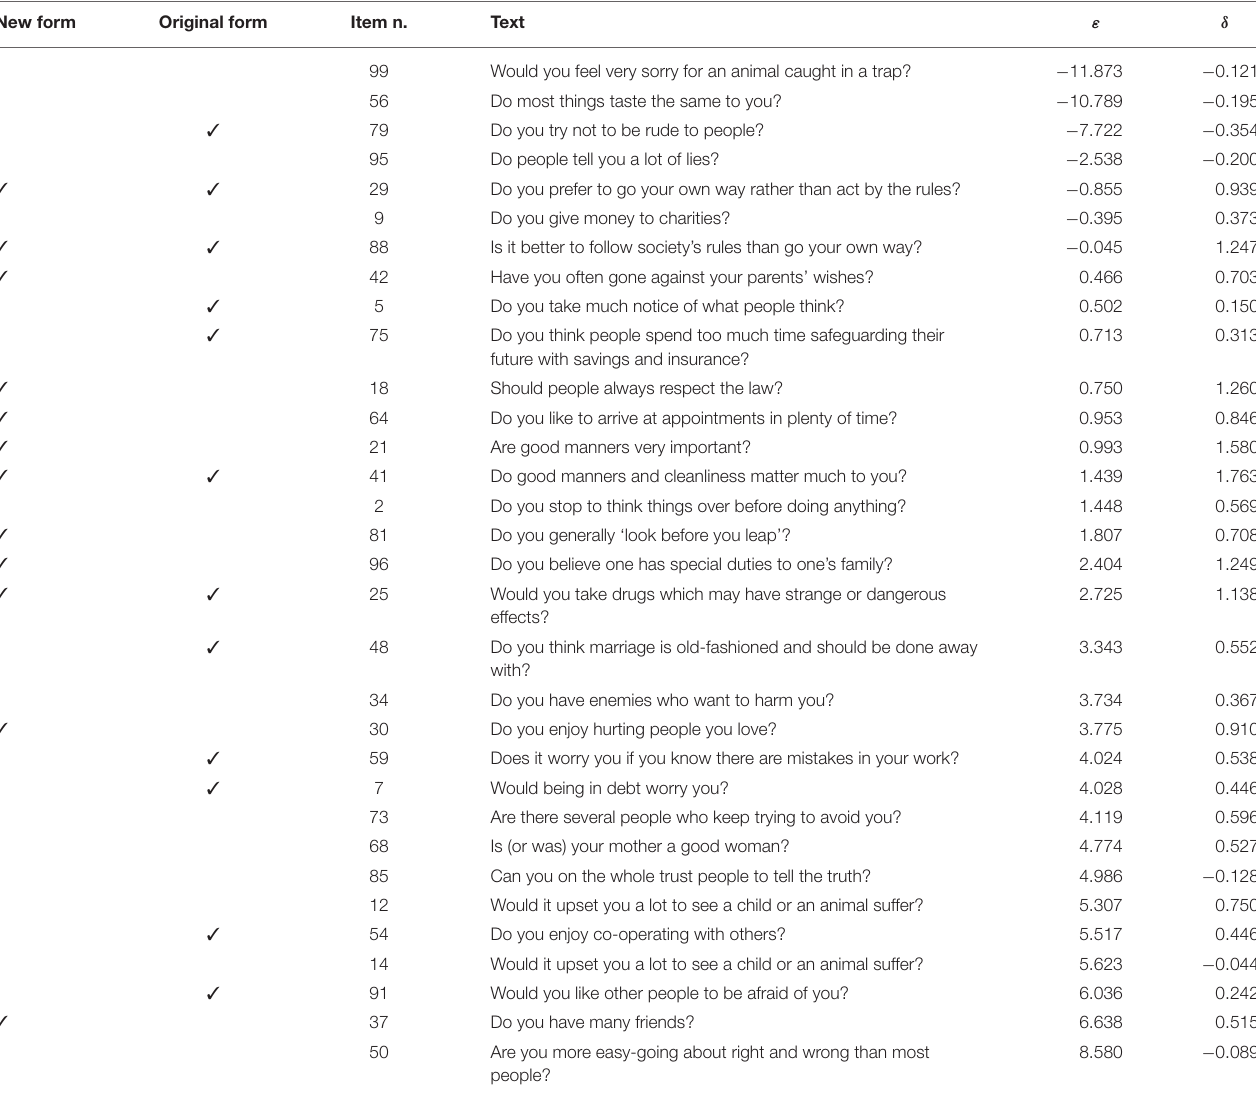
TABLE 1 | Easiness ( ε ) and discrimination ( δ ) parameters for the 32 items of the Psychoticism scale. New